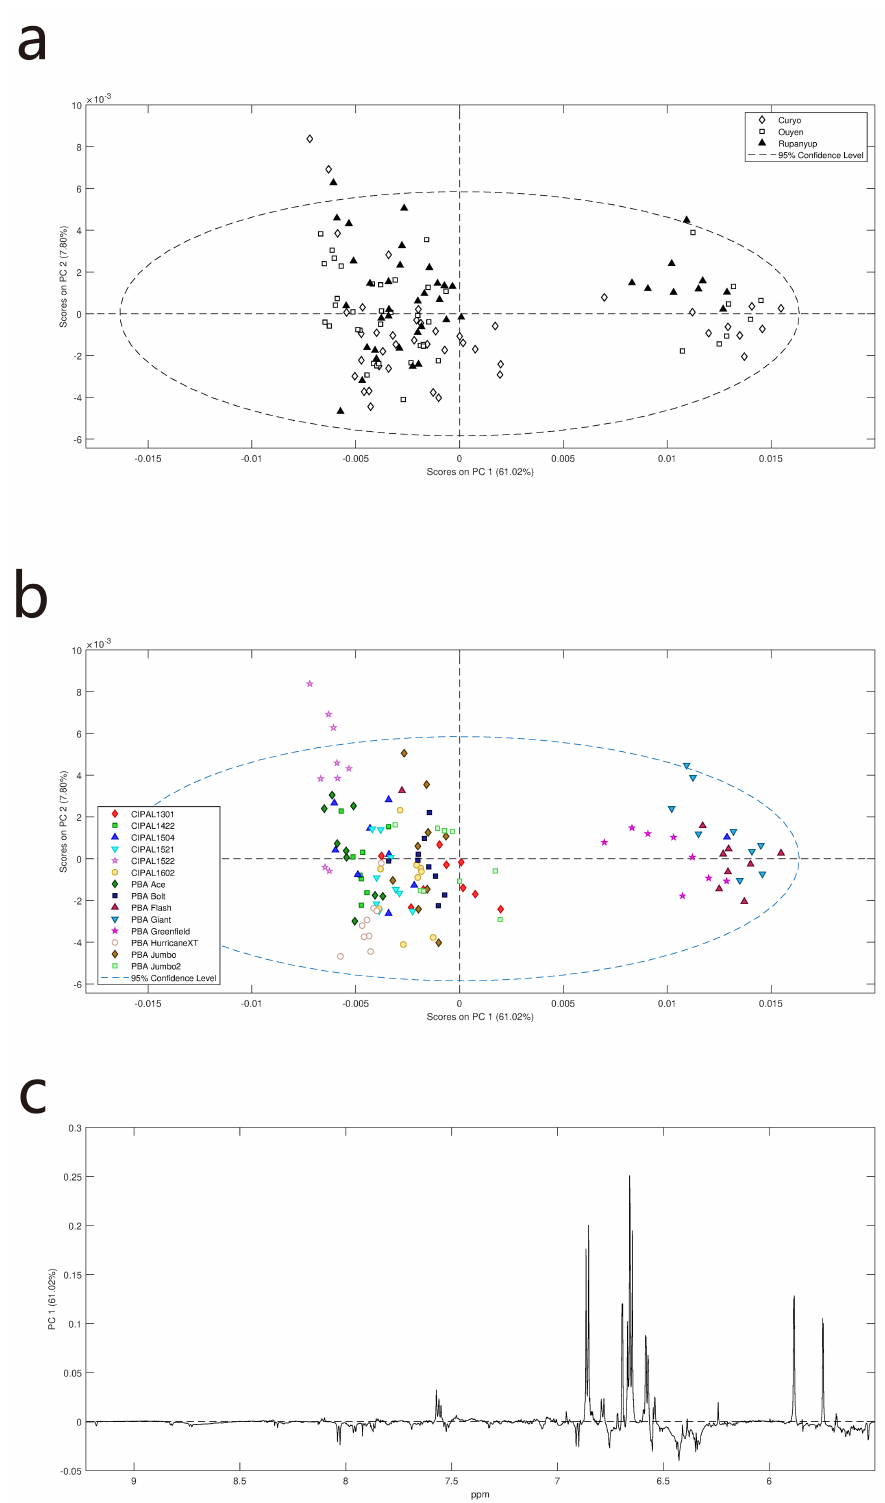
Figure 6. PCA scores and loadings plots for 1 H NMR data of lentil hulls: ( a ) PCA scores plot colored according to site; ( b ) PCA scores plot colored according to genotype; ( c ) loadings plot of PC1 variables suggest that major variation is in the levels of catechin / epicatechin derivatives and kaempferol. It appears that the concentrations of catechin / epicatechin derivatives are higher in green lentils PBA Giant, and PBA Greenfield, and in the medium-sized red lentil, PBA Flash, compared to